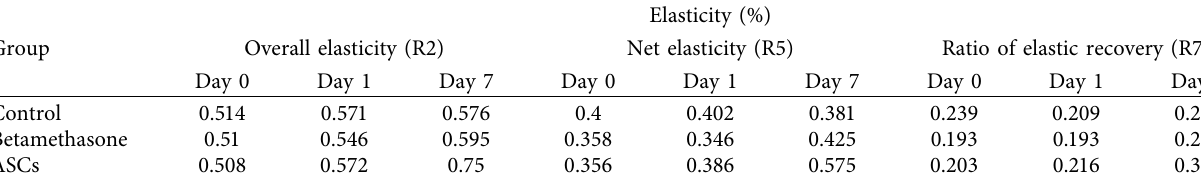
Figure 3: (a) Erythema formation and (b) sebum content of UVB-irradiated skin in treated (betamethasone and ASCs groups) and control groups on days 0, 1, and 7. Error bar: mean ± SD ( ∗ p ≤ 0.05, ∗∗ p ≤ Table 1: Percentage of overall elasticity (R2), net elasticity (R5), and the ratio of elastic recovery (R7) between three groups on days 0, 1, and 7 ( p ≤ 0.05).